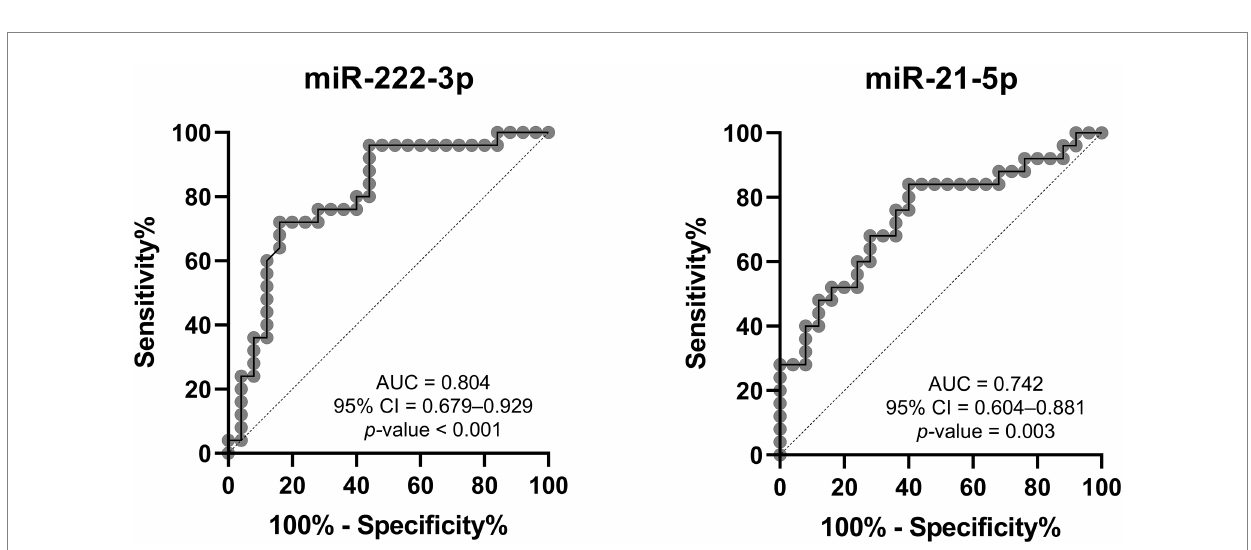
FIGURE 5 Receiver operating characteristic analysis of DE-miRNAs to discriminate between Fabry patients with stable renal function and matched controls. AUC, area under the curve; CI, confidence